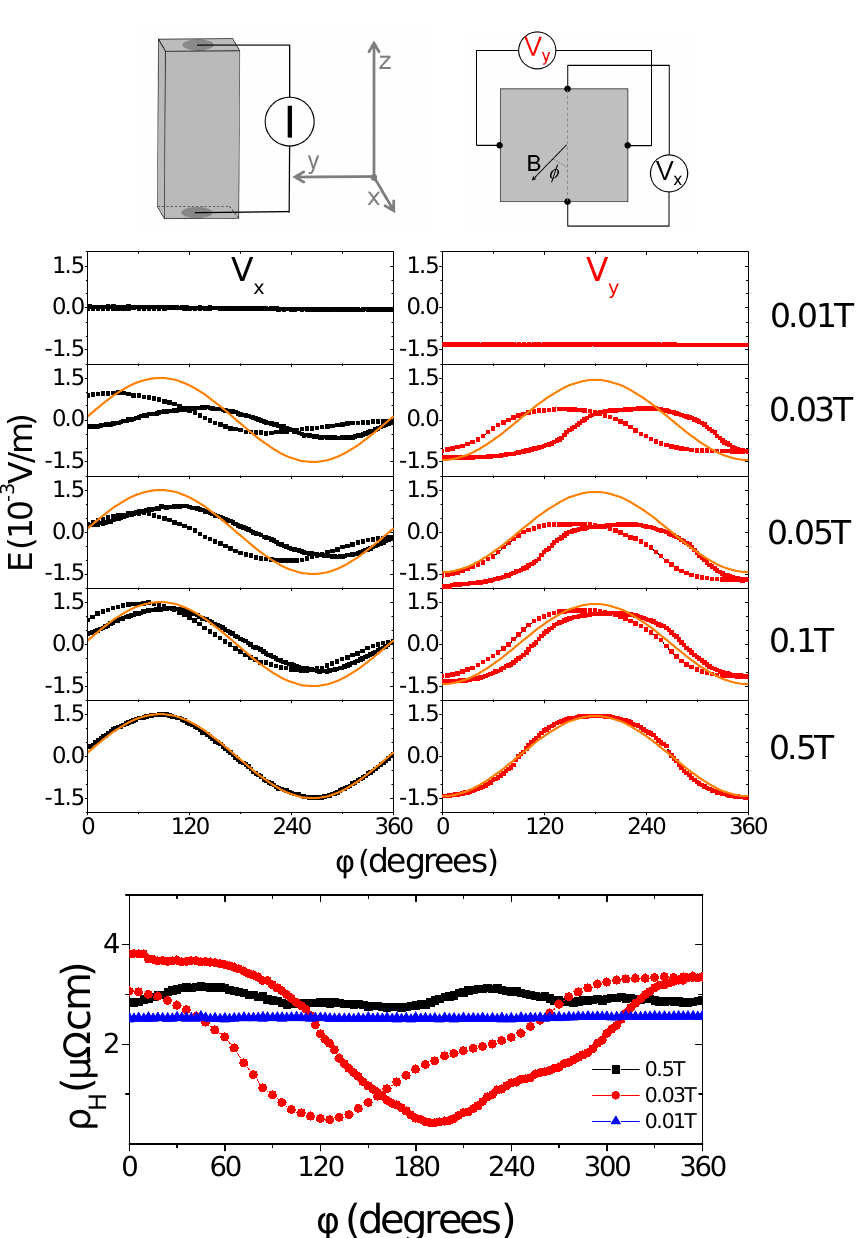
Figure S4: a) and b) The setup for measuring angle-dependent Hall resistivity in a sample with a quadrate cross-section. The current was applied along the z axis and the magnetic field was rotated in the basal plane. Two pairs of electrodes monitored the electric field along the x and y axes. c) Angular variation of E function of the angle between the magnetic field and the x axis. At low magnetic field (regime I), the total electric field remains unchanged. At high magnetic field (regime III), for both orientations, the measured electric field presents almost sinu- soidal variation with almost no hysteresis. In the intermediate field range (regime II), the angular variation is strongly hysteretic. (e) The total Hall resistivity as a function of the